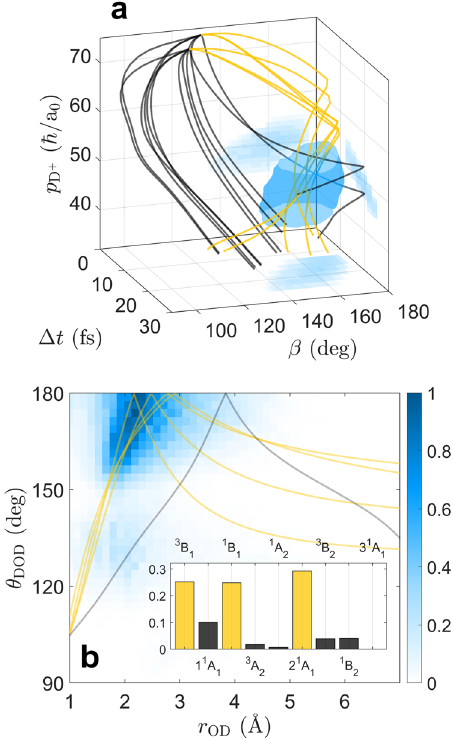
Fig. 4 Localizing the enhancement in D 2 O 2 + → D 2 O 3 + . a A 3-dimensional representation (in p D þ , β , and Δ t ) of the volume over which the enhanced trication production is within 50% of its maximum value (in semi- transparent cyan). 2-dimensional projections of the enhancement volume are displayed (in faded cyan) on the three walls of the plot. Two sample trajectories on each of the nine states of D 2 O 2 + are also plotted within this 3-dimensional space. The trajectories on the states that undergo rapid slingshot motion are drawn in yellow, and those on the states that do not are drawn in black. b A 2-dimensional histogram of OD bond distance ( r OD ) and bend angle ( θ DOD ) created by a weighted sum of the simulated trajectories. Five sample trajectories from ( a ) are reproduced in ( b ). The weighted state populations are shown in the inset of ( b ). Those depicted in yellow undergo rapid slingshot motion and those in black do